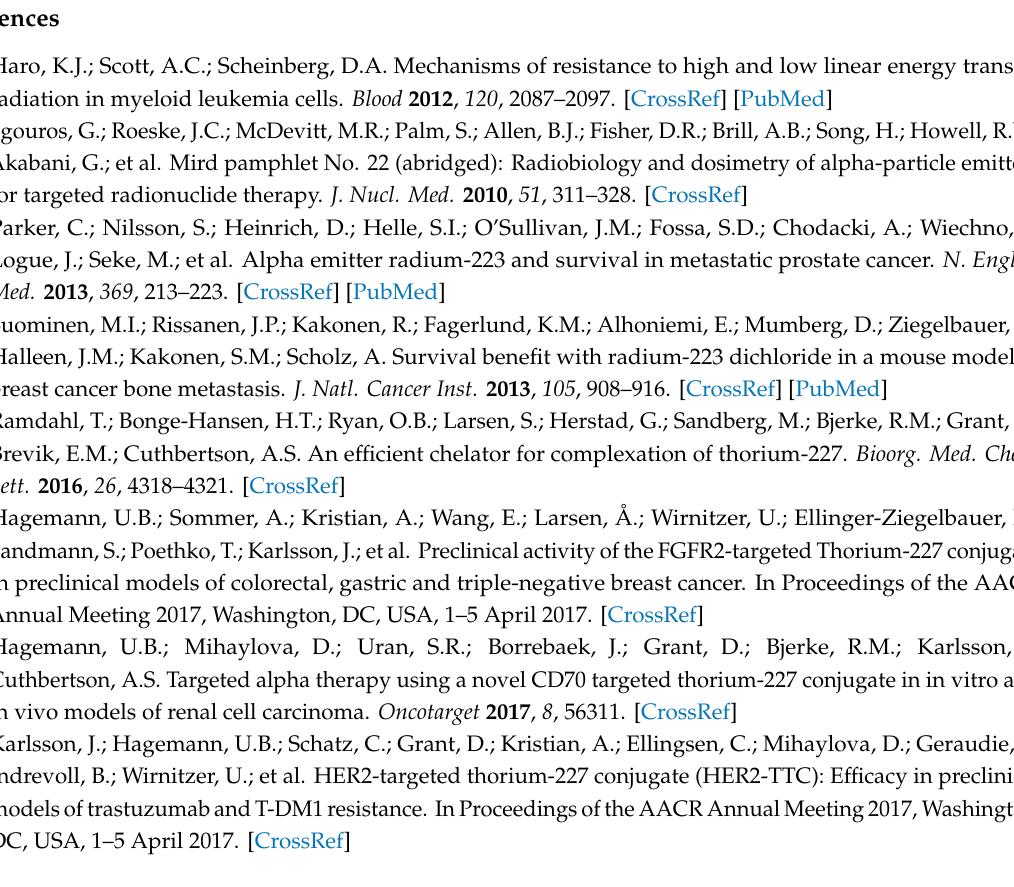
Table S2. Overview of determined % IA / g from biodistribution studies in the DLD-1 parental and DLD-1 BRCA2 - / - xenograft models. Table S3: BLISS analysis DLD-1 BRCA2 - / -. Table S4: BLISS analysis DLD-1